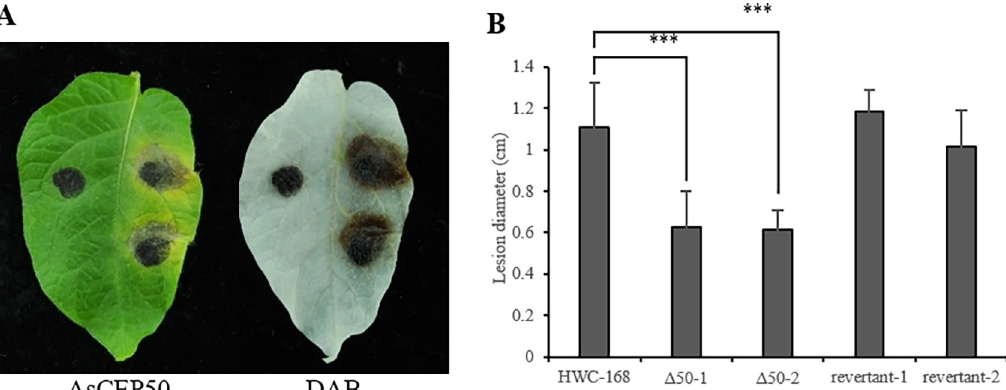
Fig 7. Pathogenicity detection of AsCEP50 gene. ( A ) The detached potato leaves were inoculated with the spore suspensions of Δ 50 mutant strains (left, leaf tip to petiole direction), wild-type strains (upper right, leaf tip to petiole direction) and revertant strains (lower right, leaf tip to petiole direction). ( B ) The lesion diameters of potato leaves infected by the wild-type, Δ 50 -1 mutant, Δ 50 -2 mutant, revertant-1 and revertant-2 strains. ��� , indicates an extremely significant difference (p < 0.001) compared with the control (HWC-168). Bar means standard deviation (SD).